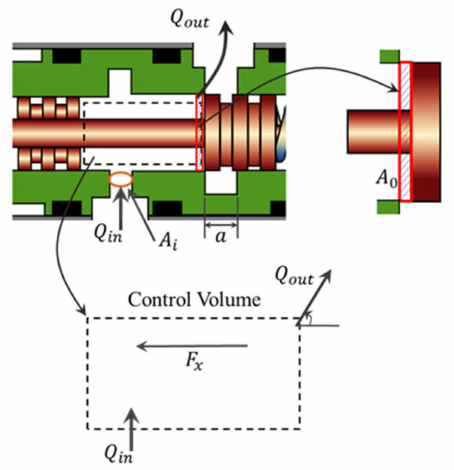
Figure 3. Control volume of the spool